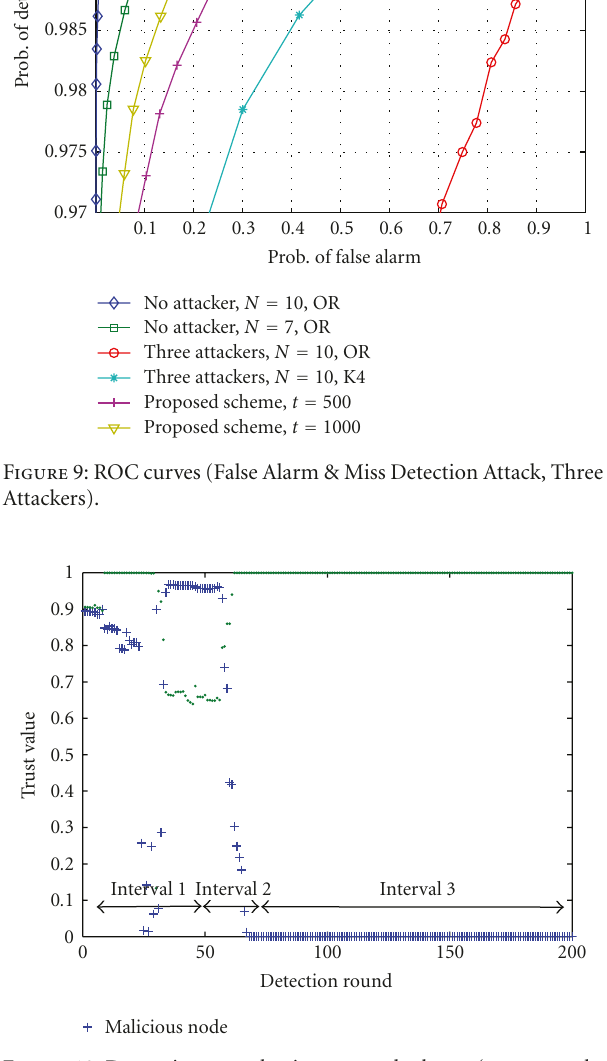
Figure 10: Dynamic trust value in proposed scheme (a user attacks during time [50,90], P a = 1).